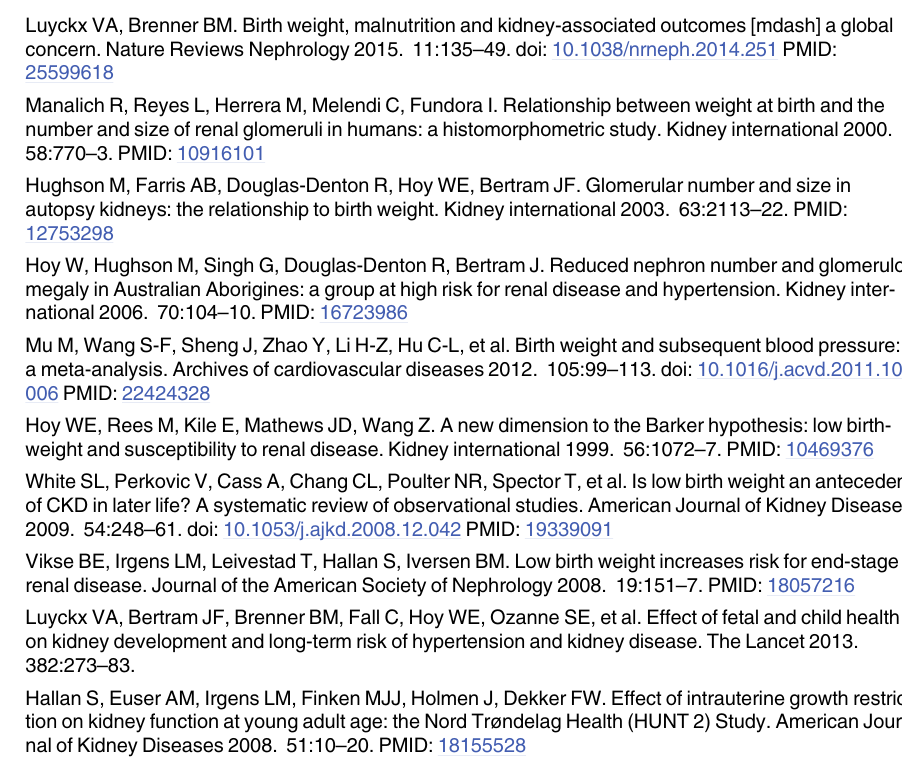
S1 Table. Cohort characteristics at the time of IgAN diagnosis stratified by development of ESRD. S2 Table. Clinical and histopathological characteristics at the time of biopsy and risk of